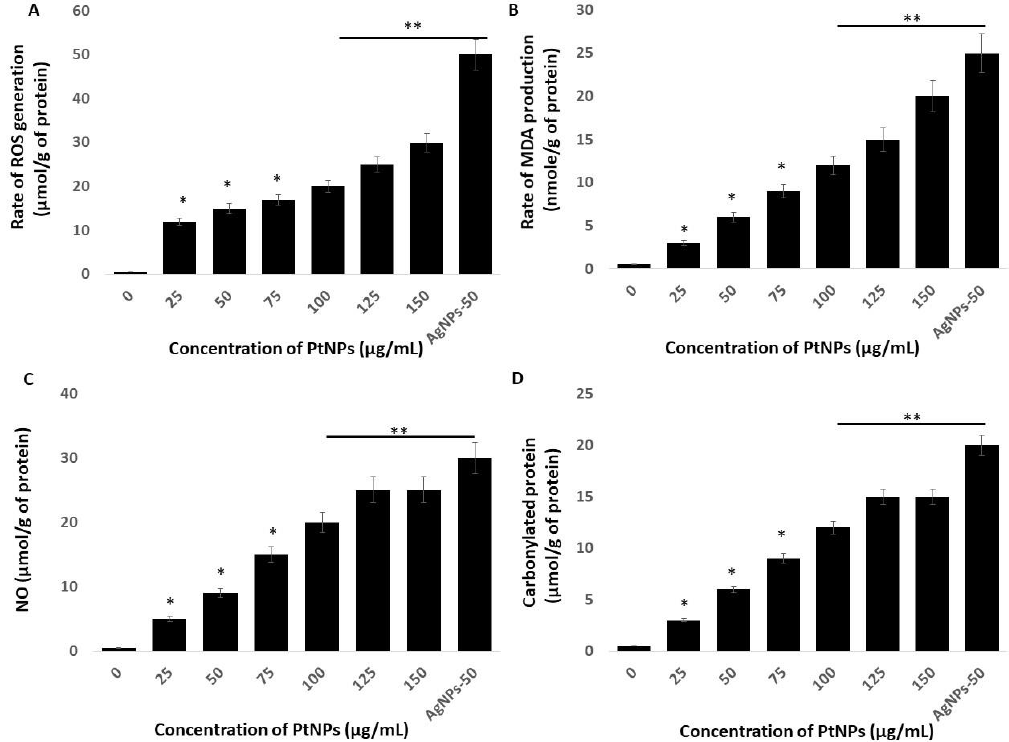
Figure 5. PtNPs increase generation of reactive oxygen species (ROS), lipid peroxidation, nitric oxide (NO), and protein carbonylation ( A ) THP-1 cells were treated with PtNPs (25–150 µ g / mL) for 24 h. Spectrophotometric analysis of ROS using DCFH-DA. ( B ) Malondialdehyde (MDA) concentration was measured using a thiobarbituric acid-reactive substances assay and is expressed as nanomoles per gram of protein. ( C ) NO production was quantified spectrophotometrically using the Griess reagent and is expressed as micromoles per gram of protein ( D ). Protein carbonylation content was determined and is expressed as micromoles per gram of protein. The results are expressed as means ± standard deviation of three independent experiments. The treated groups showed statistically significant di ff erences from the control group by the Student’s t -test (* p < 0.05; ** p < 0.01). * significant; ** highly significant.